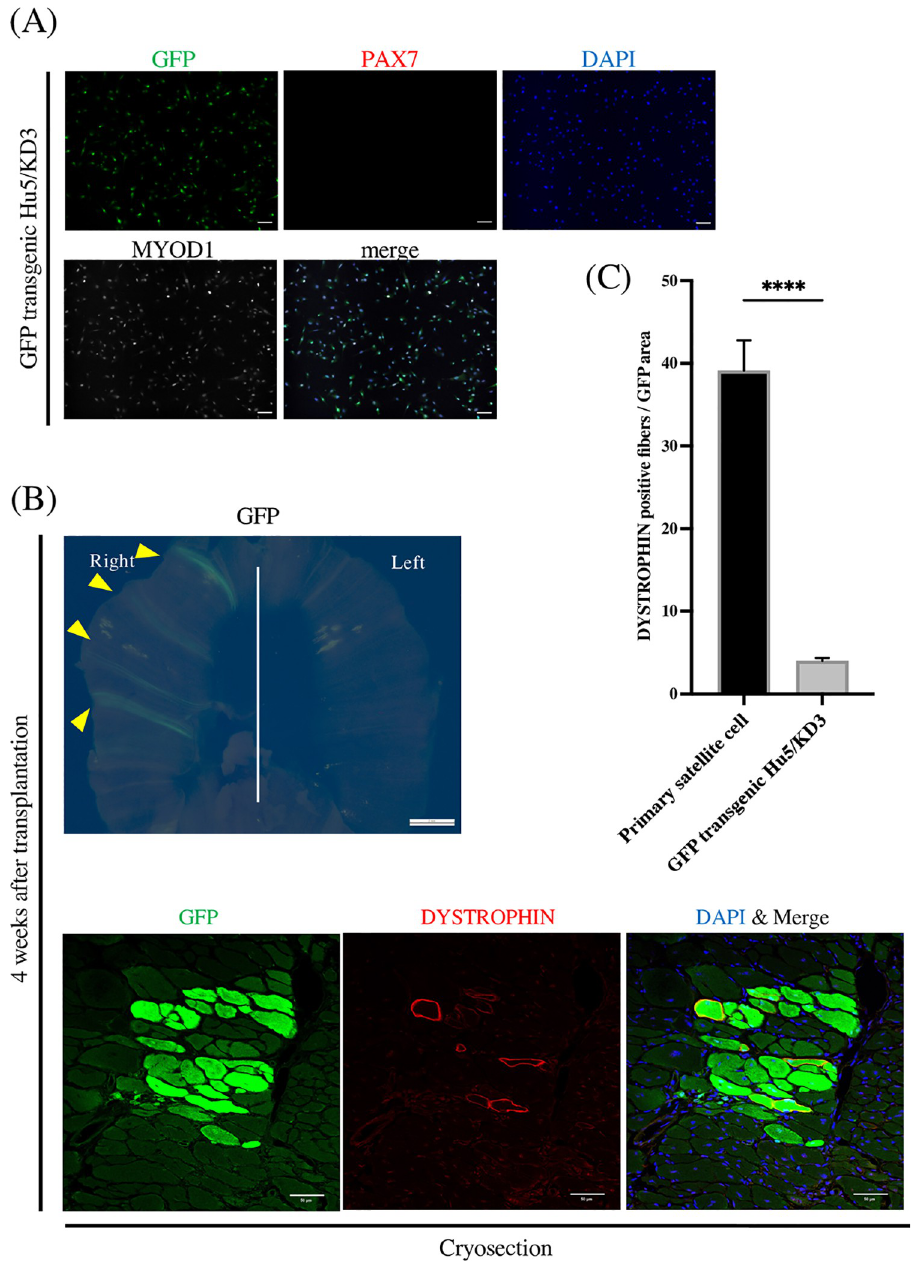
Fig 2. Human immortalized myoblasts in the diaphragm show limited engraftment. (A) Immunocytochemistry staining of GFP-transgenic Hu5/KD3 in culture. Cells were stained with anti-PAX7 antibody (red), anti-MYOD1 antibody (white), and DAPI (blue). Scale bars, 100 μ m. (B) A representative fluorescence stereomicroscopy image of the diaphragm 4 weeks after the transplantation of GFP-transgenic Hu5/KD3 (upper panel). Scale bar, 2 mm. Arrowheads show GFP. Immunohistochemistry staining of the image (lower panel). The image was stained with anti- DYSTROPHIN antibody (red) and anti-GFP antibody (green). Nuclei were stained with DAPI (blue). Scale bars, 50 μ m. (C) Quantification of DYSTROPHIN positive fibers in the transplanted areas. Data show the mean ± SEM (two-tailed Student’s t-test; ���� p < 0.0001) and are from three independent experiments. Three mice were used in one experiment. There were in total 87 primary satellite cells and 78 GFP transgenic Hu5/KD3 cells in the respective GFP areas.